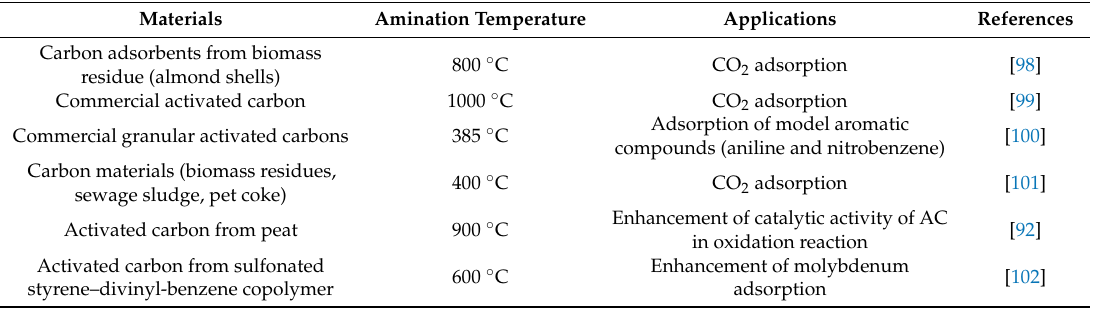
Table 3. Recent research studies conducted on the modification of activated carbon with gaseous